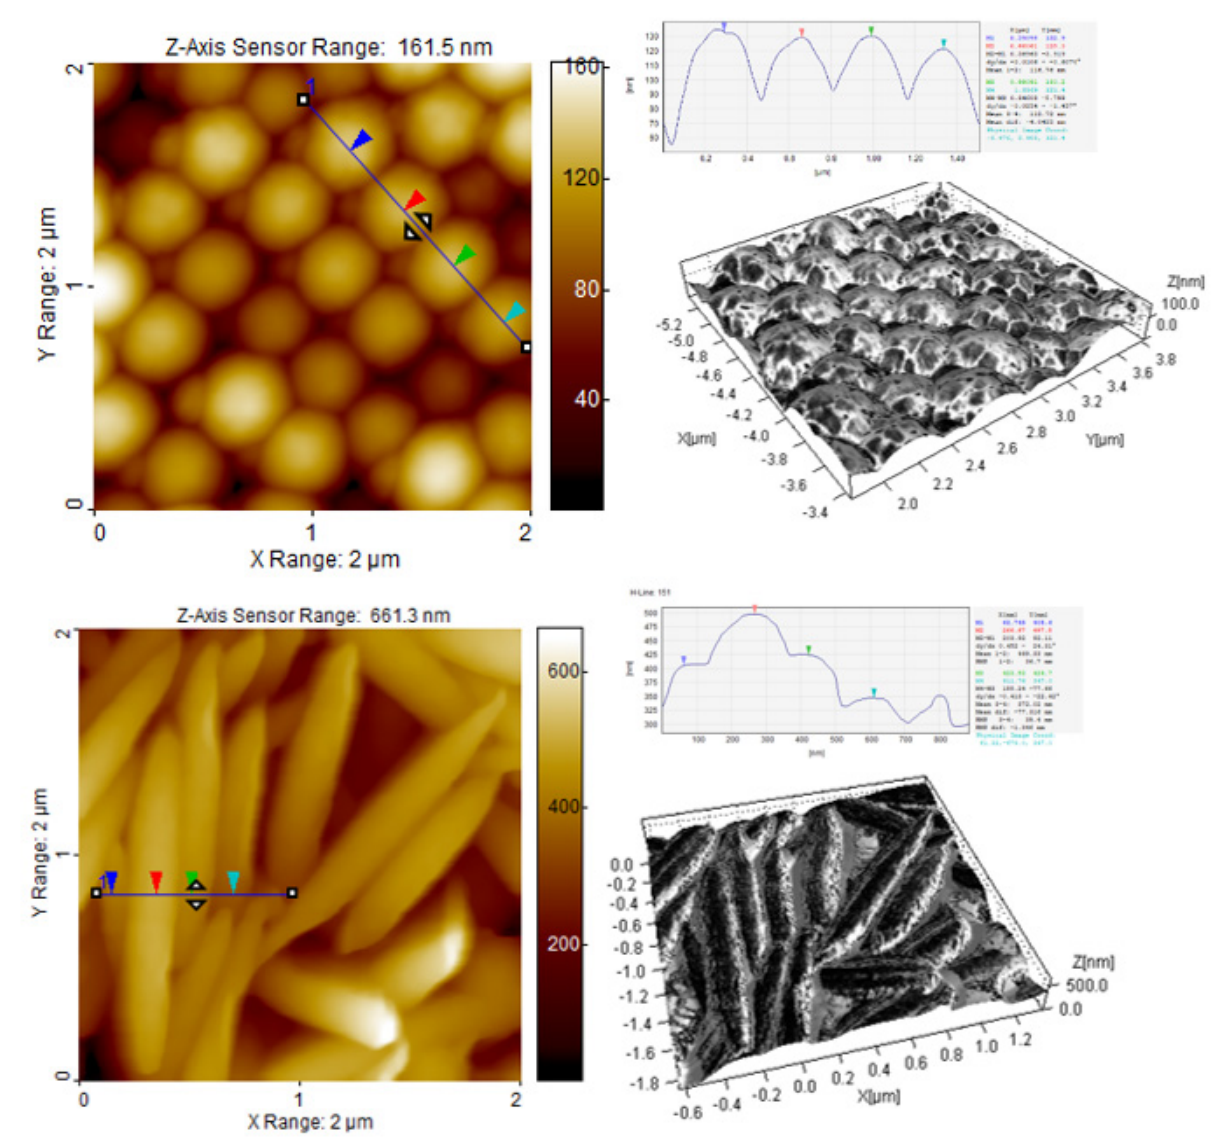
Figure 2. AFM height images of spherical and spheroidal ( AR = 6.41) particle multilayers and 3D AFM phase contrast images of P(S/PGL) m and P(S/PGL) s 3 particles deposited from aqueous sus-